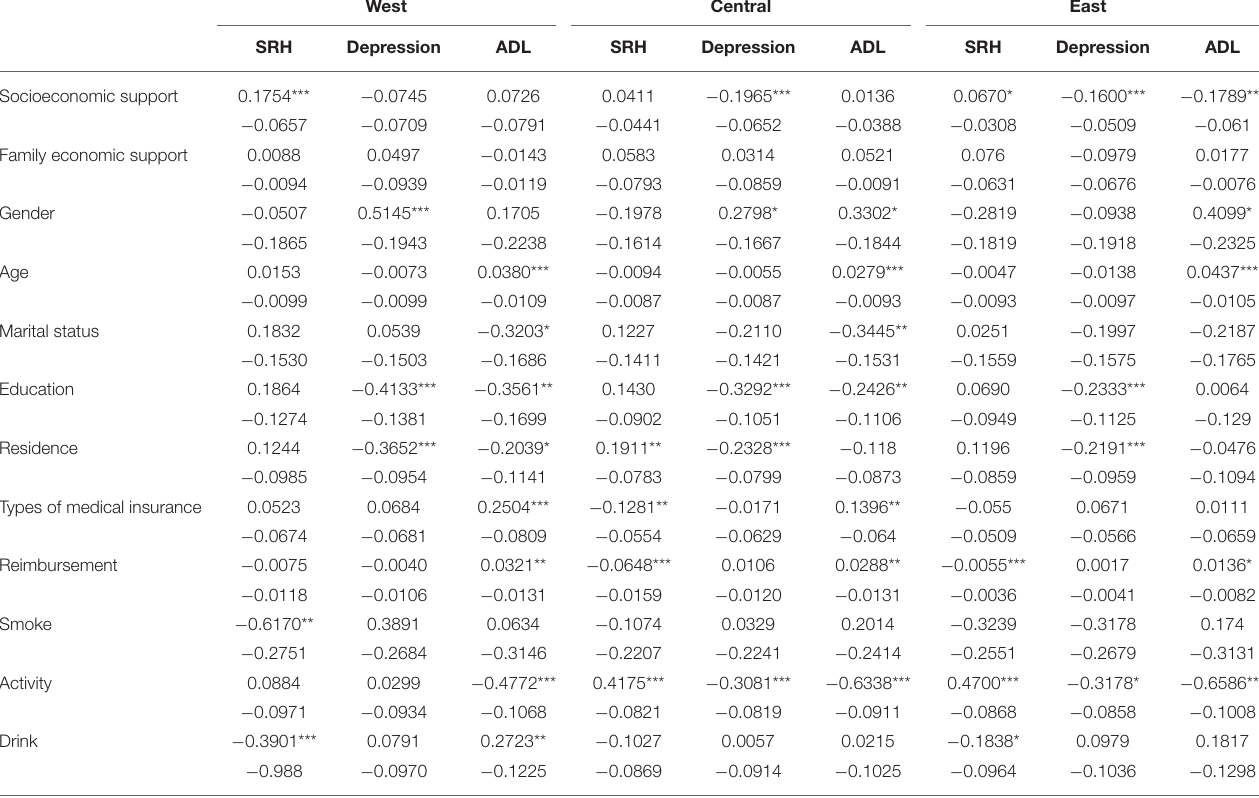
TABLE 5 | Regional differences in economic